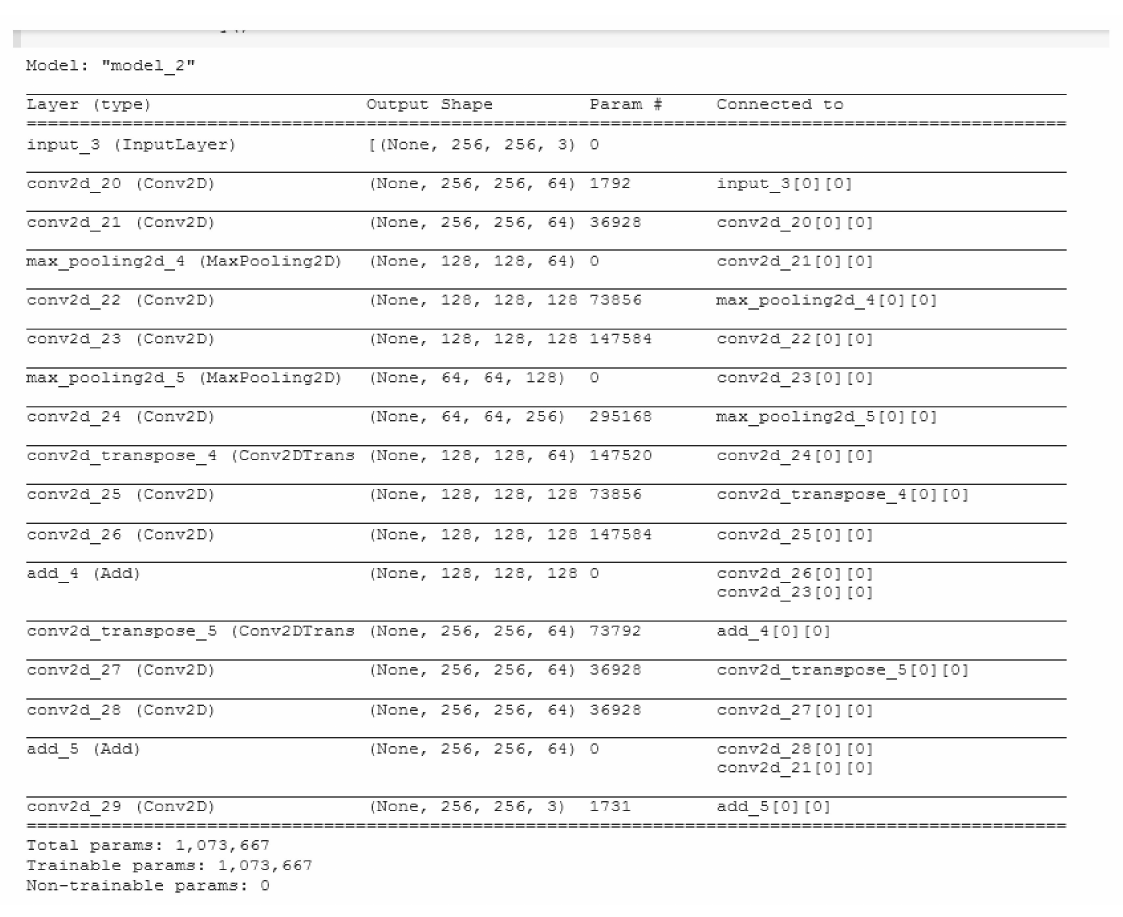
Figure 14. Modified Convolutional